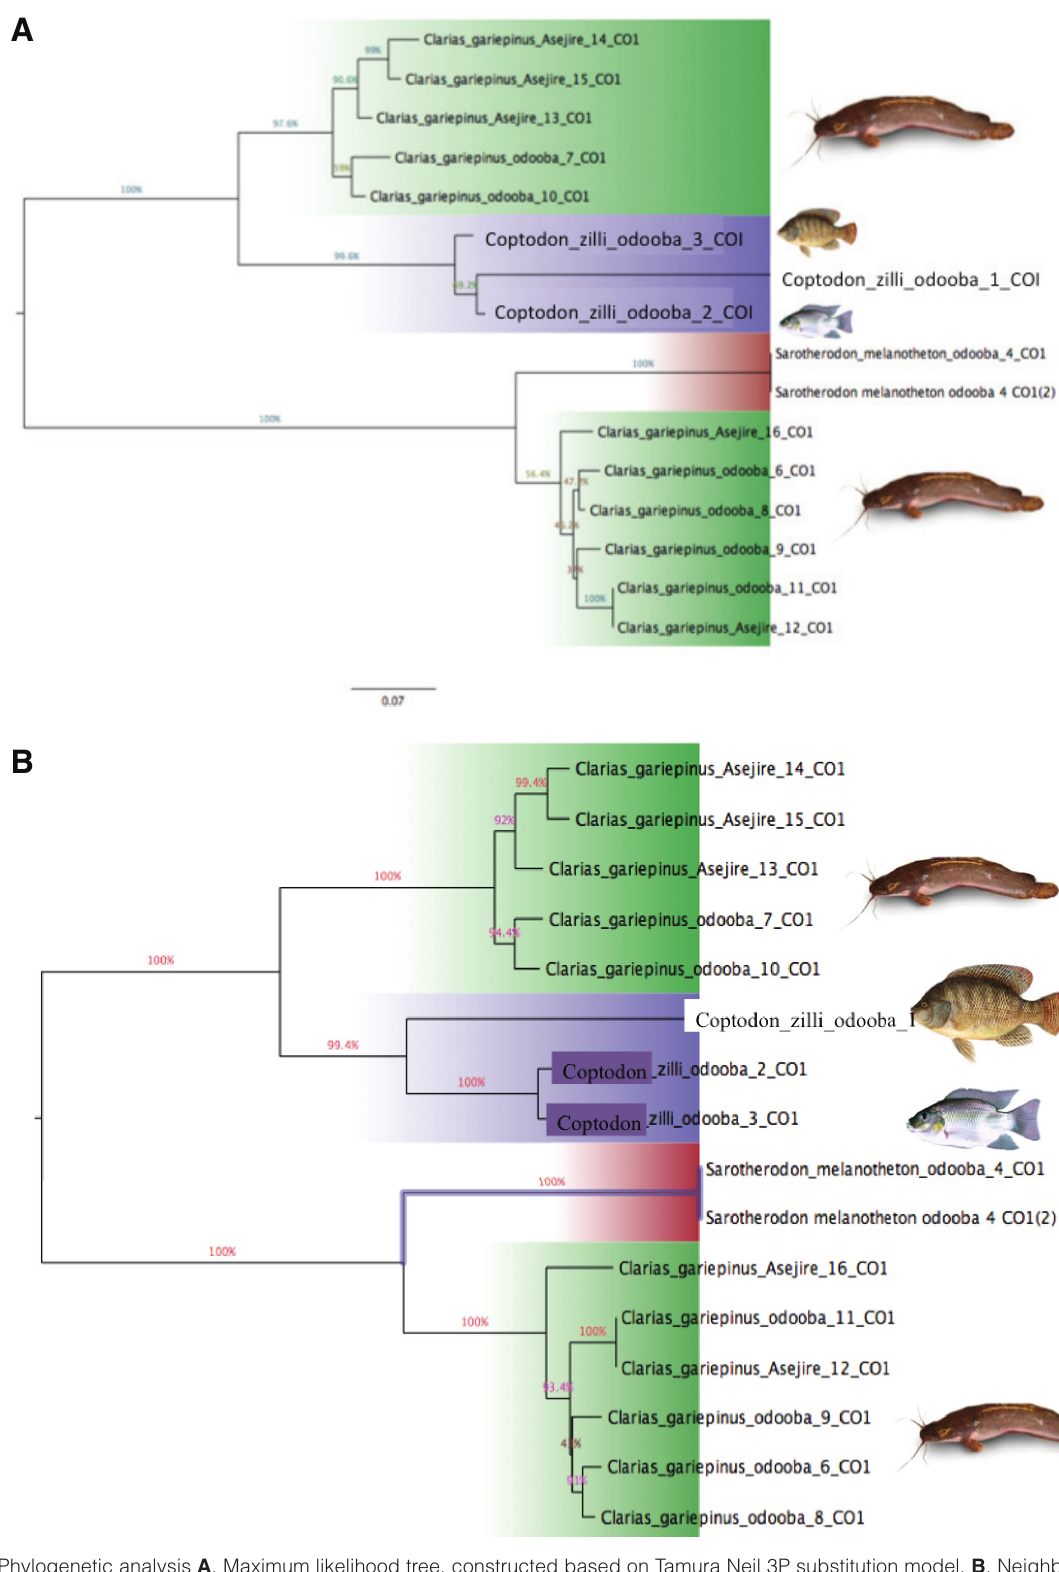
Figure 1. Phylogenetic analysis A . Maximum likelihood tree, constructed based on Tamura Neil 3P substitution model. B . Neighbour-joining trees based on number of difference model, constructed from COI gene sequences (Bootstrap test was 1000